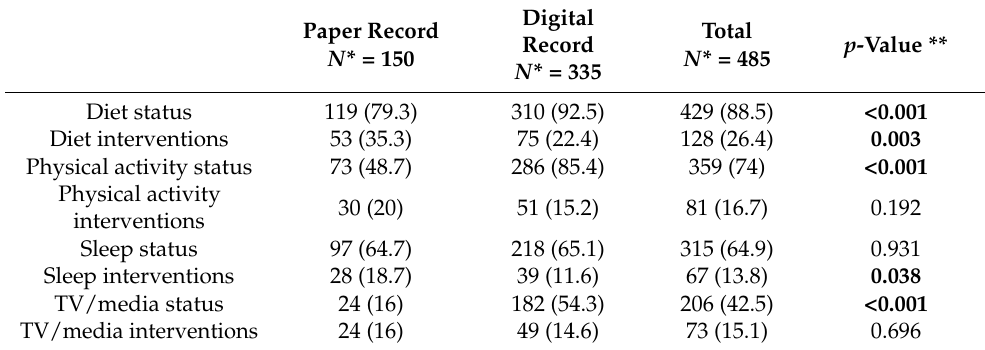
Table 2. Documentation of status and interventions regarding lifestyle habits in relation to record system. Paper